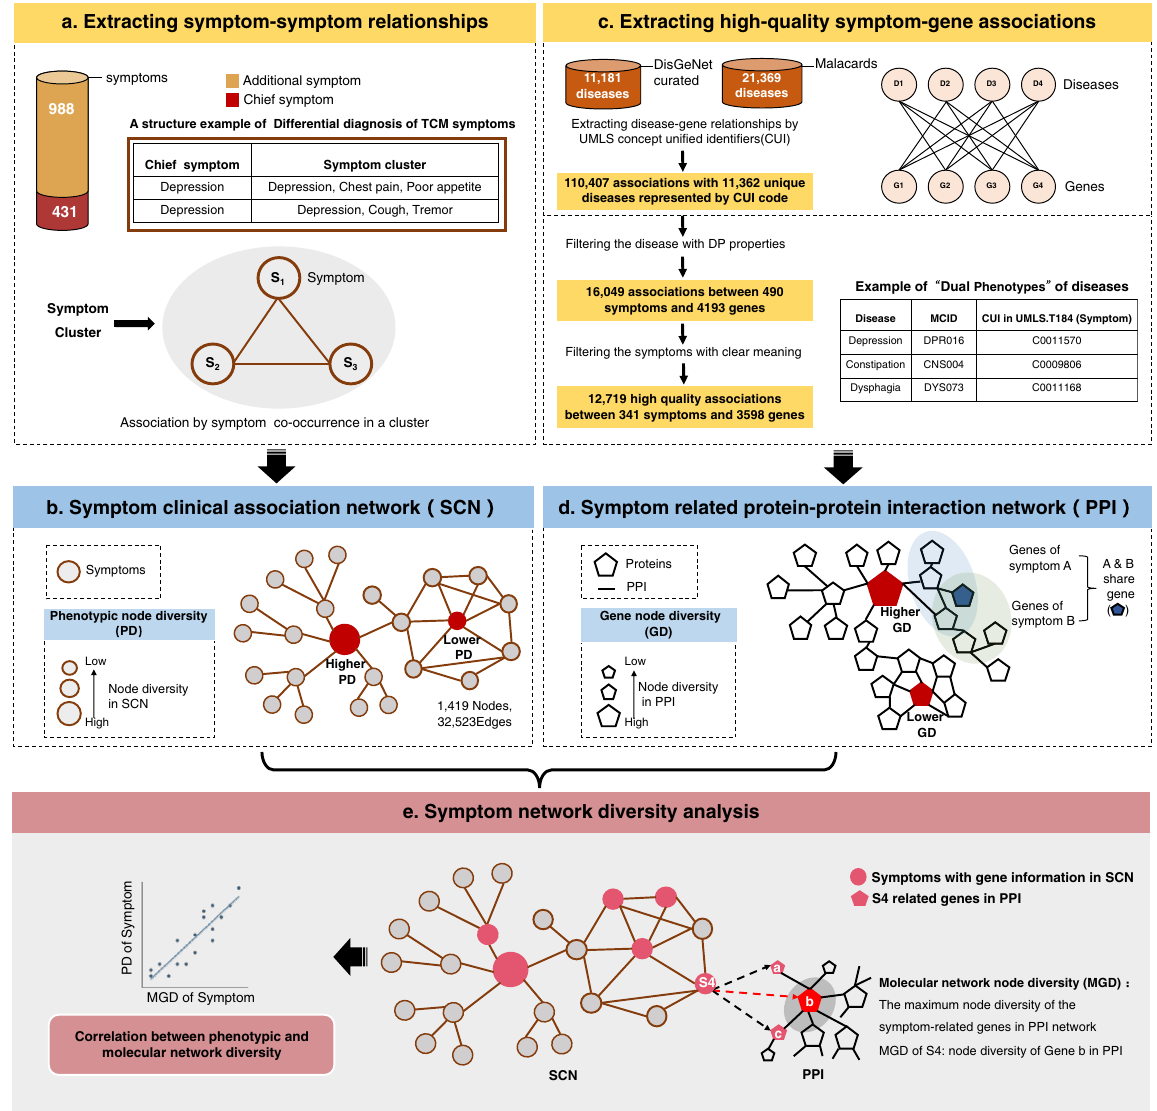
Fig. 1 Quantifying the phenotypic and molecular network diversity of symptom phenotypes. a Curation of symptom-symptom relationships. The associations between symptoms are based on their co-occurrence in a symptom cluster of a textbook named differential diagnosis of traditional Chinese medicine symptom . b Constructing symptom clinical association network. The nodes represent symptoms and size re fl ects the phenotypic diversity in network. c Extracting high-quality symptom-gene associations. d Integrating both symptom-gene associations and protein – protein interaction (PPI) database to obtain molecular network diversity of symptom phenotypes. e The main steps of symptom network diversity analysis. We measured symptom diversity from both phenotypic and molecular network